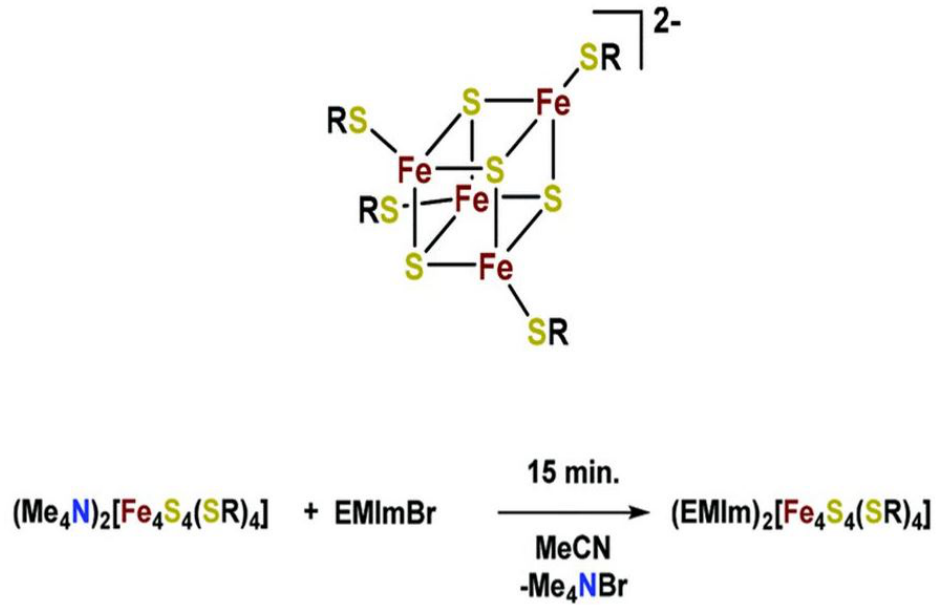
Figure 4. The upper figure shows the general structure of cubane-type iron–sulfur clusters, and the lower figure shows the synthesis scheme of iron–sulfur cluster-based ionic liquids. Adapted from the article written by Modrzynski et al. [16] under a Creative Commons Attribution License 3.0 (CC-BY-NC